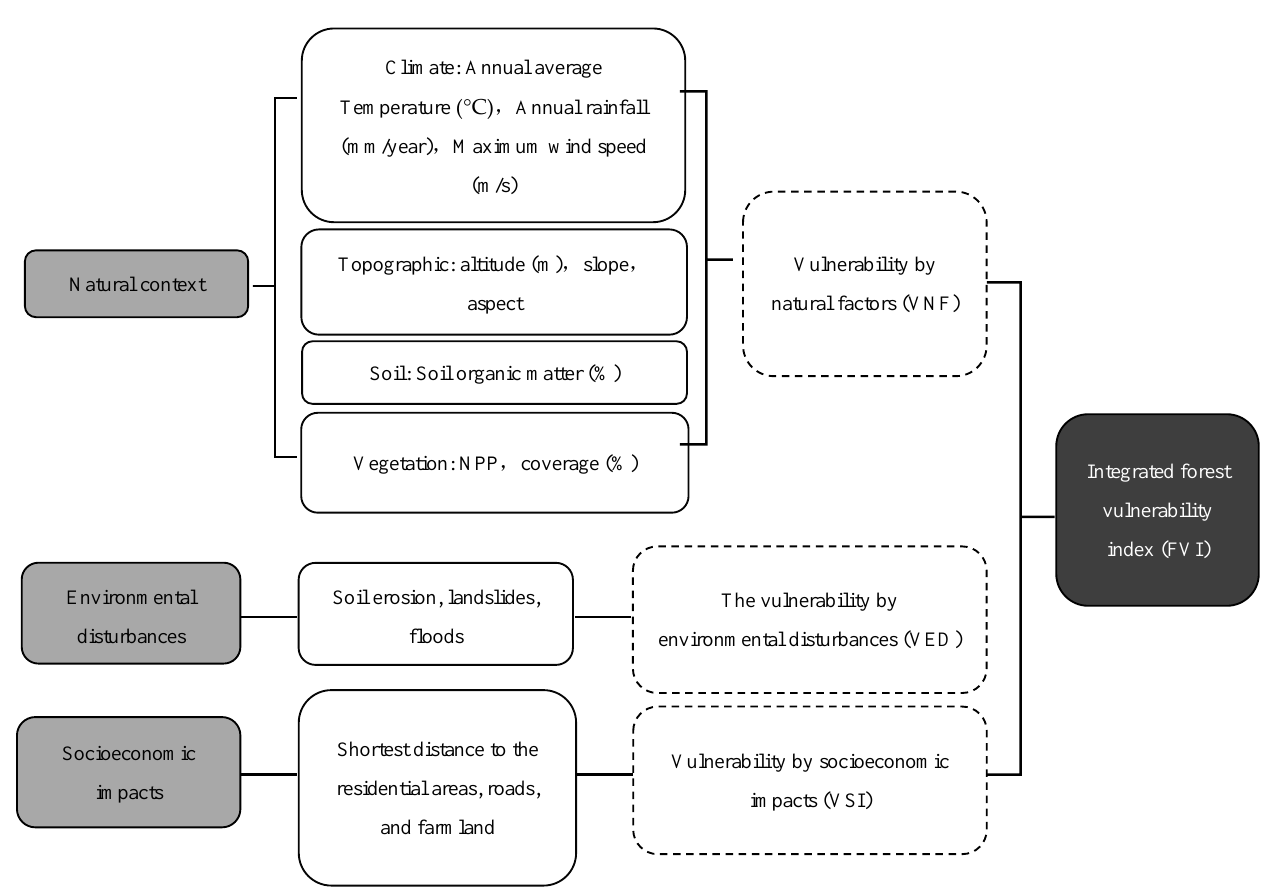
Figure 2. Schematic representation of the forest vulnerability evaluation.